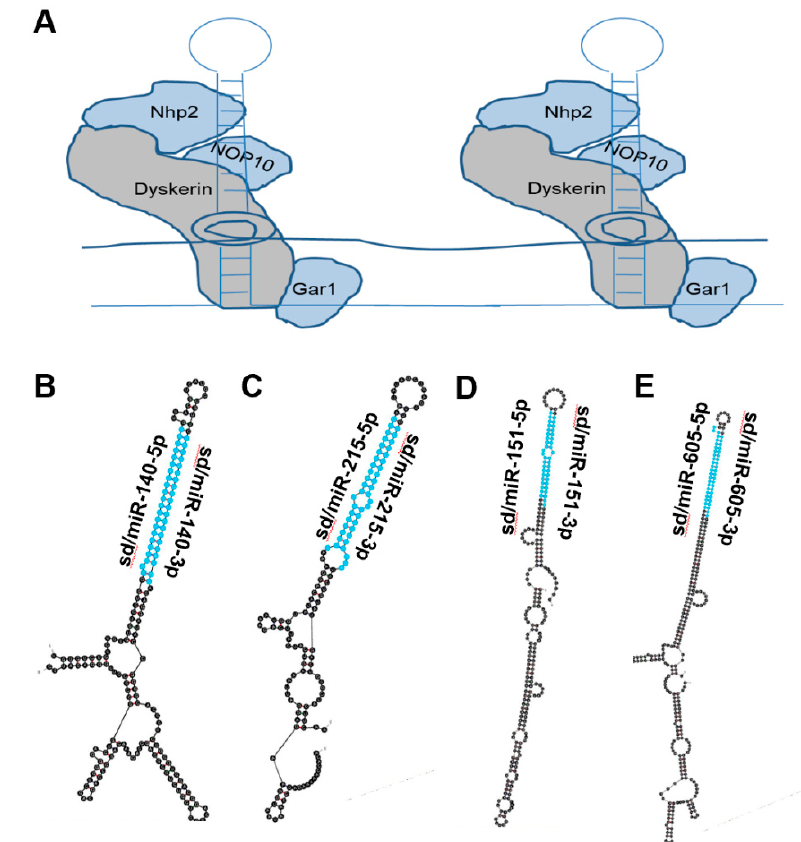
Figure 3. miRNAs derived from Box H/ACA snoRNA-like transcripts that bind dyskerin. ( A ) Figure Schematic of box H/ACA snoRNA bound to dyskerin complex, giving rise to snoRNP. Dyskerin complex includes Dyskerin, NHP2, NOP10, and GAR1 [18]. ( B – E ) Most thermodynamically stable